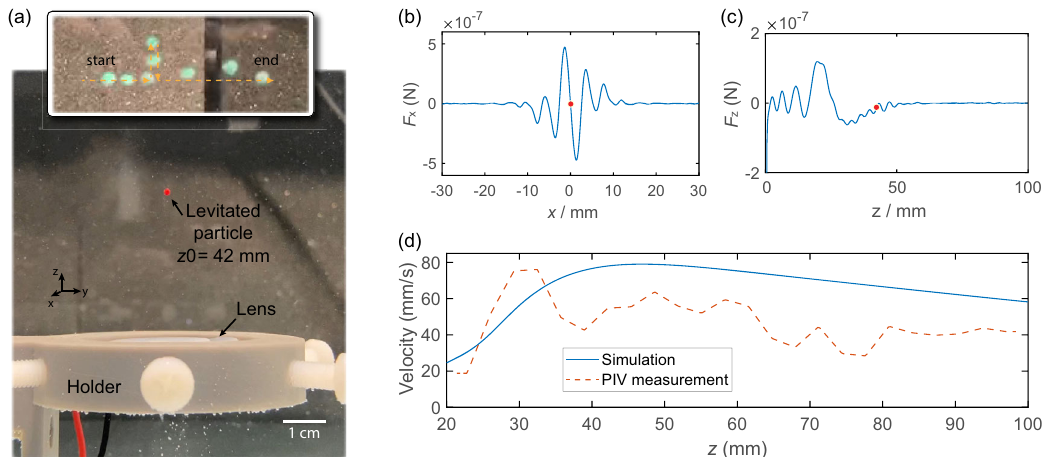
Fig. 4 Experimental demonstration of particle levitation and movement. a The red particle is stably trapped in 3D at z 0 = 42 mm (Supplementary Movie 1). The inset shows the trace of a particle moving along a designed path outlined by the yellow arrows. The particle closely follows the 3D motion of the lens (Supplementary Movie 4). b Radiation force along x direction in the plane where particle is trapped. The red dot denotes the particle position. c Radiation force along z -axis. d Streaming velocity along z -axis in simulation and Particle imaging velocimetry (PIV) measurement, showing a fl ow velocity gradient that creates the trap along the z